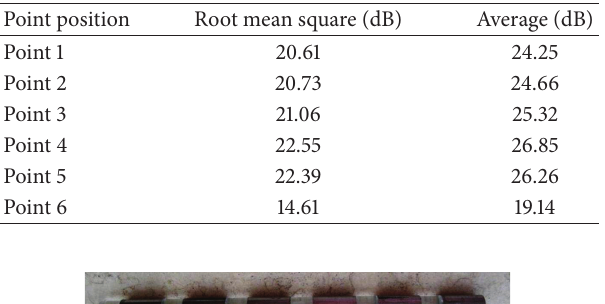
Table 1: Comparison of the attenuation of the output points.